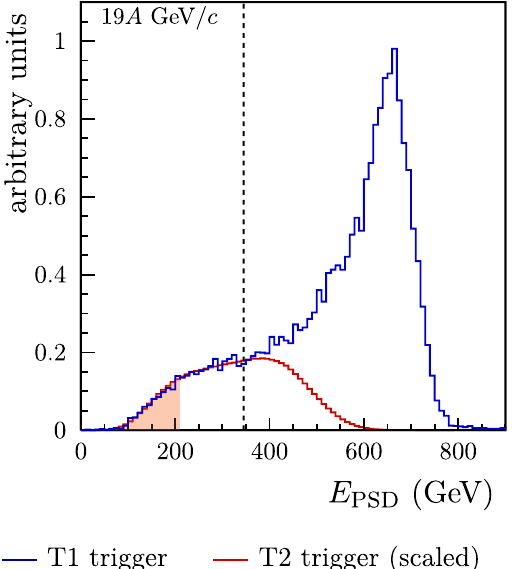
(from the beginning of the distribution to the black dashed line). The T2 trigger was set to accept ≈ 30% of the inelastic cross section. The accepted region corresponding to the 5% collisions with the smallest E PSD is indicated by shading